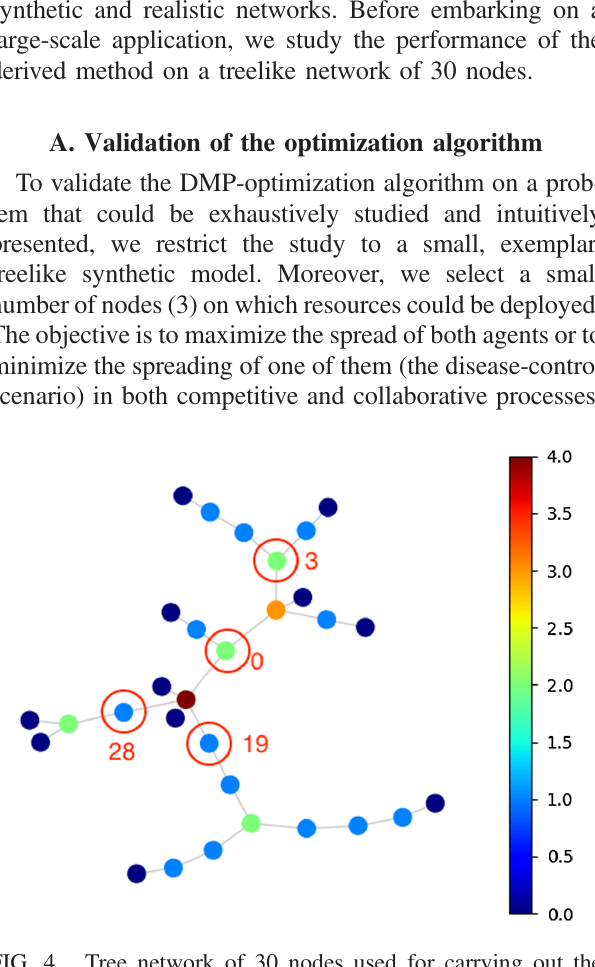
FIG. 4. Tree network of 30 nodes used for carrying out the experiments. The color scale represents the degree of nodes. Controllable nodes in the various experiments are